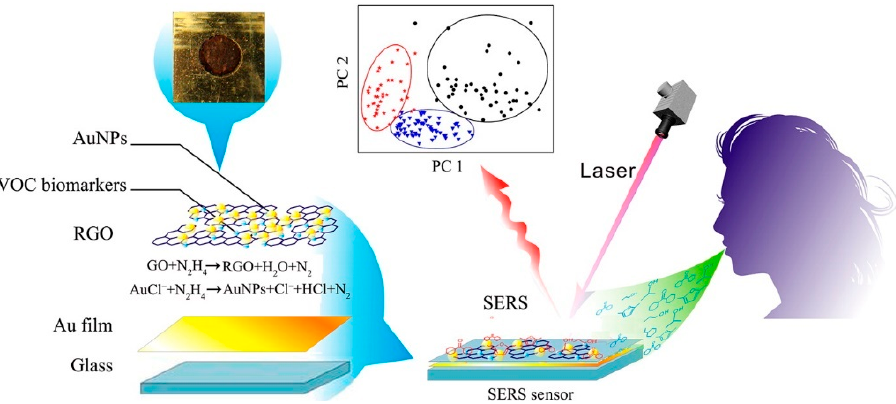
Figure 11. SERS sensor for analysis of breath VOC biomarkers utilizing AuNPs. Reprinted with permission from [154] without modification. Copyright 2016 American Chemical Society.